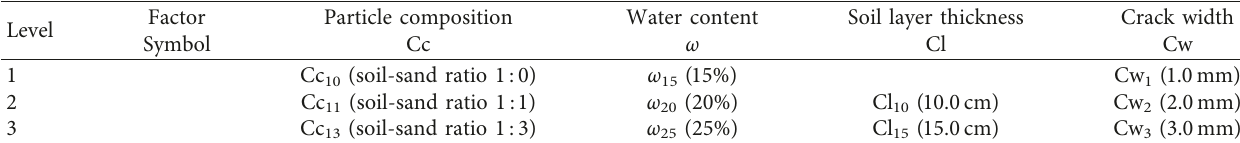
Figure 7: Production drawing of cracks in soil: (a) iron wires of different diameters; (b) crack fabrication process; (c) crack Table 1: Experimental factors and their level values.